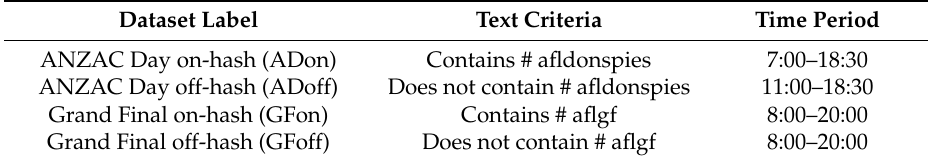
Table 2. Summary of text and temporal sampling criteria for each micro-blog dataset (times are